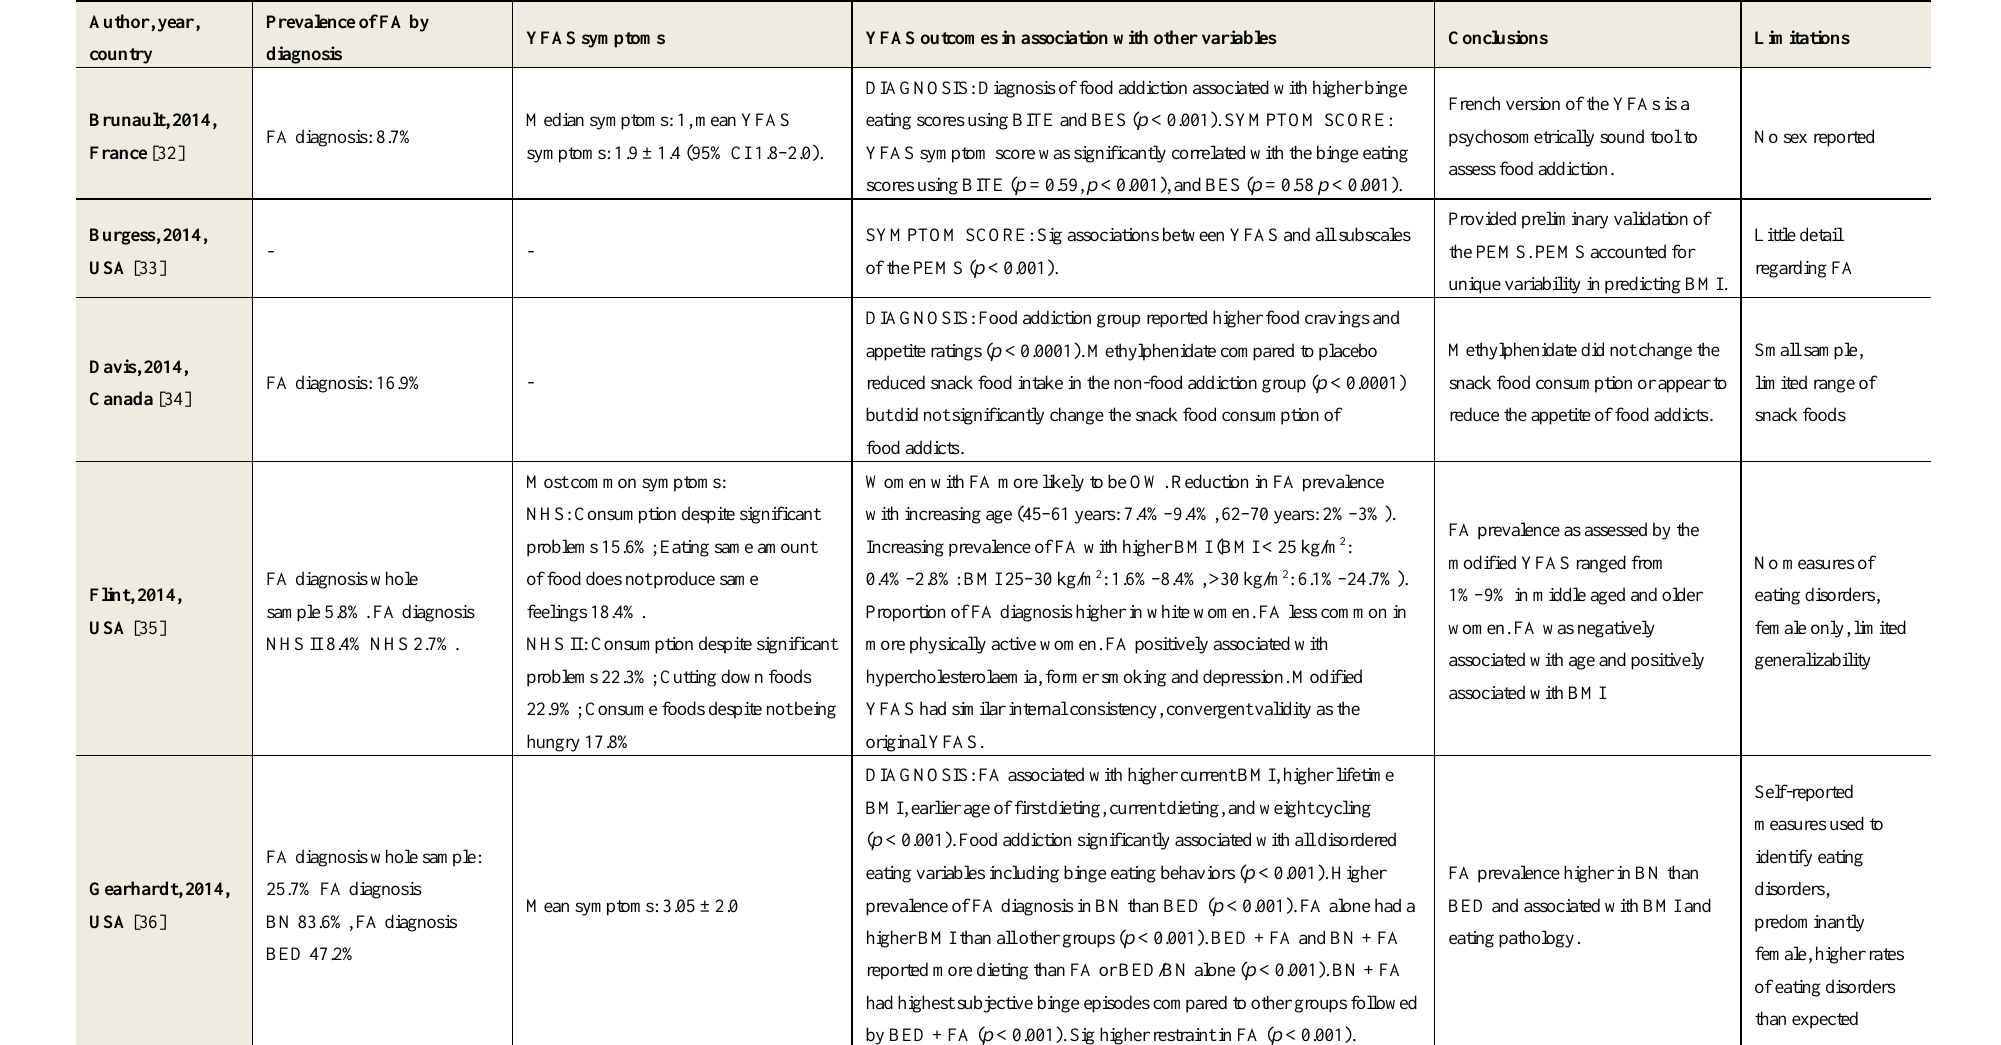
Table 3. Results of included studies using the Yale Food Addiction Scale to assess food